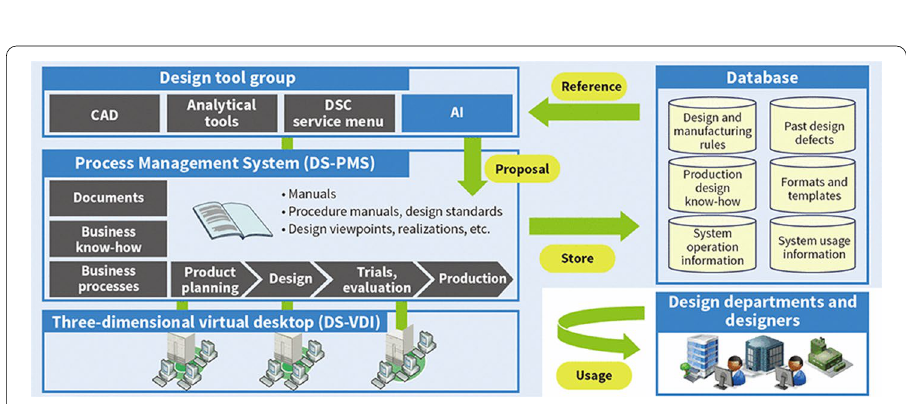
Fig. 2 On-site O&M operations based on the smart O&I